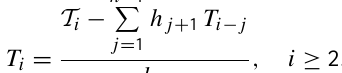
Earth Syst. Sci. Data www.earth-syst-sci-data.net